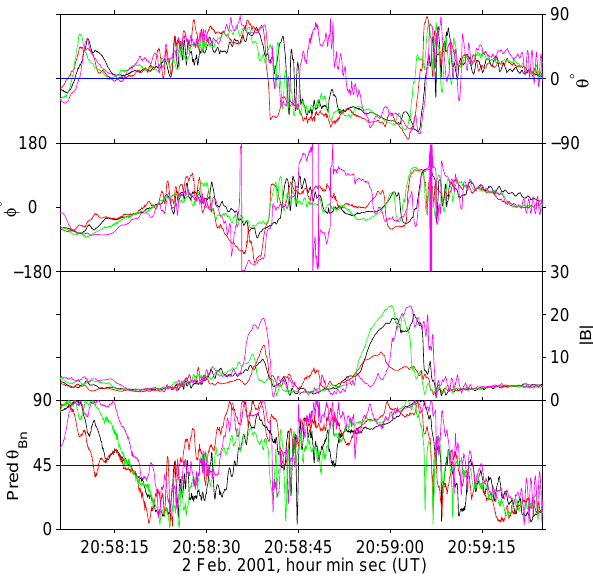
Fig. 8. Magnetic field data at 22 vectors/s in GSE coordinates, in the same format at Fig. 5.